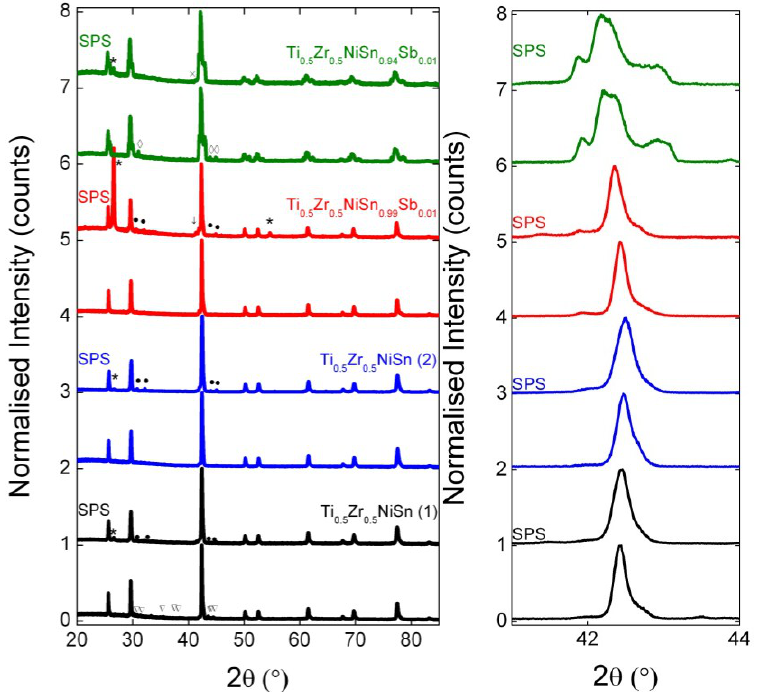
Figure 1. Comparison of pre- and post-SPS X-ray powder diffraction patterns for the >95% dense Ti 0.5 Zr 0.5 NiSn 1/0.95−y Sb y samples. Impurities are labelled as follows: * = graphite, ● = Sn,  = Ni 3 Sn 4 , ↓ = Ti 2 Ni and ◊ =